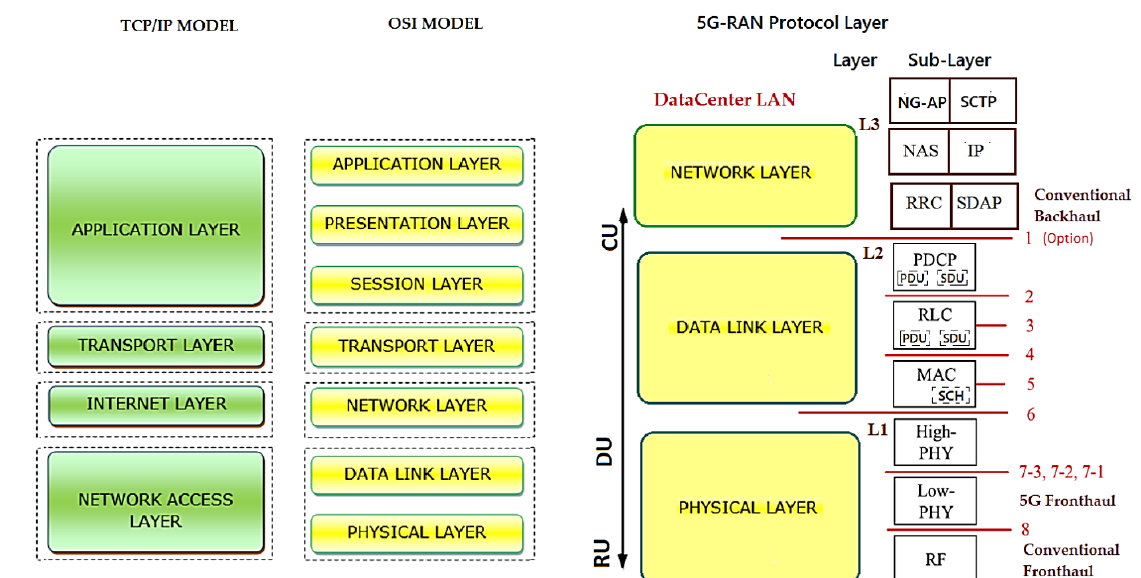
Figure 4. Radio protocol stack simplified in the UMTS/LTE/5G air interface or datacenter LAN with 4G/LTE/5G RAN Network stacks—Comparison to have the “5G NR/NGC SA Protocol Stack”. Based on